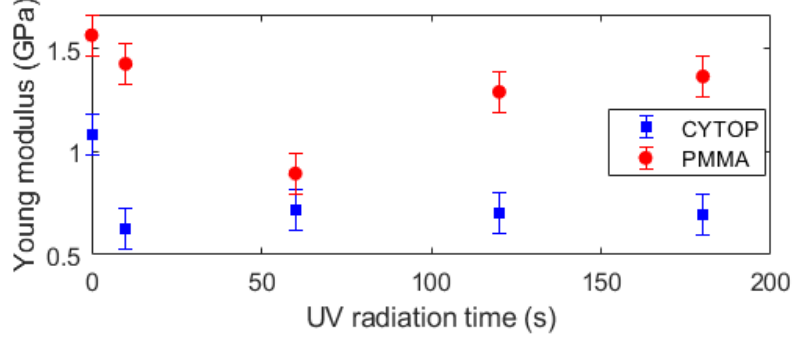
Figure 3. Young’s modulus of PMMA and CYTOP samples at different UV radiation times.